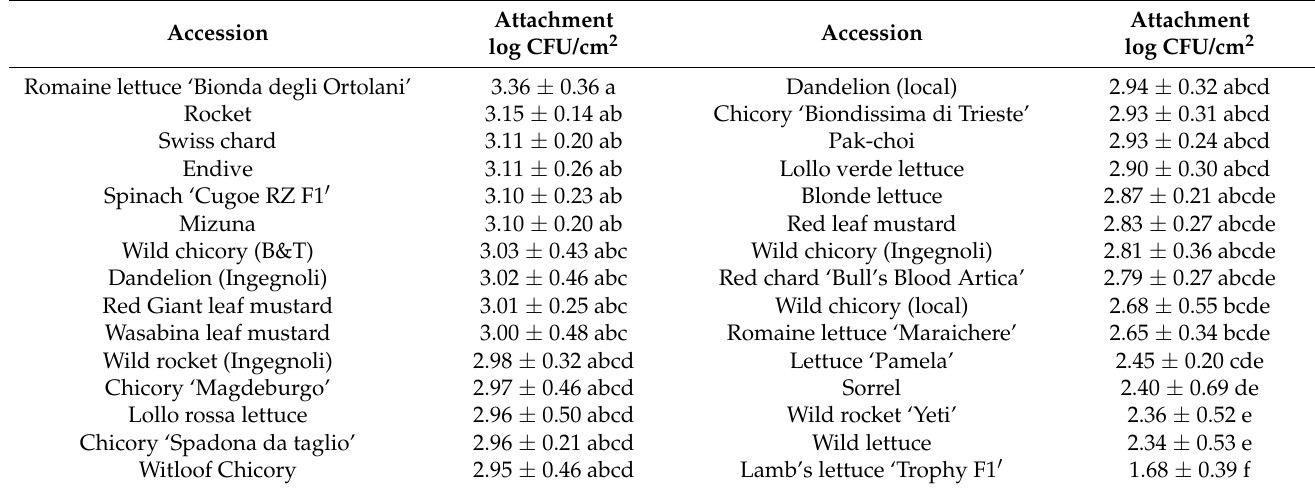
Table 2. E. coli ATCC 35218 attachment in 30 accessions of baby leaves.